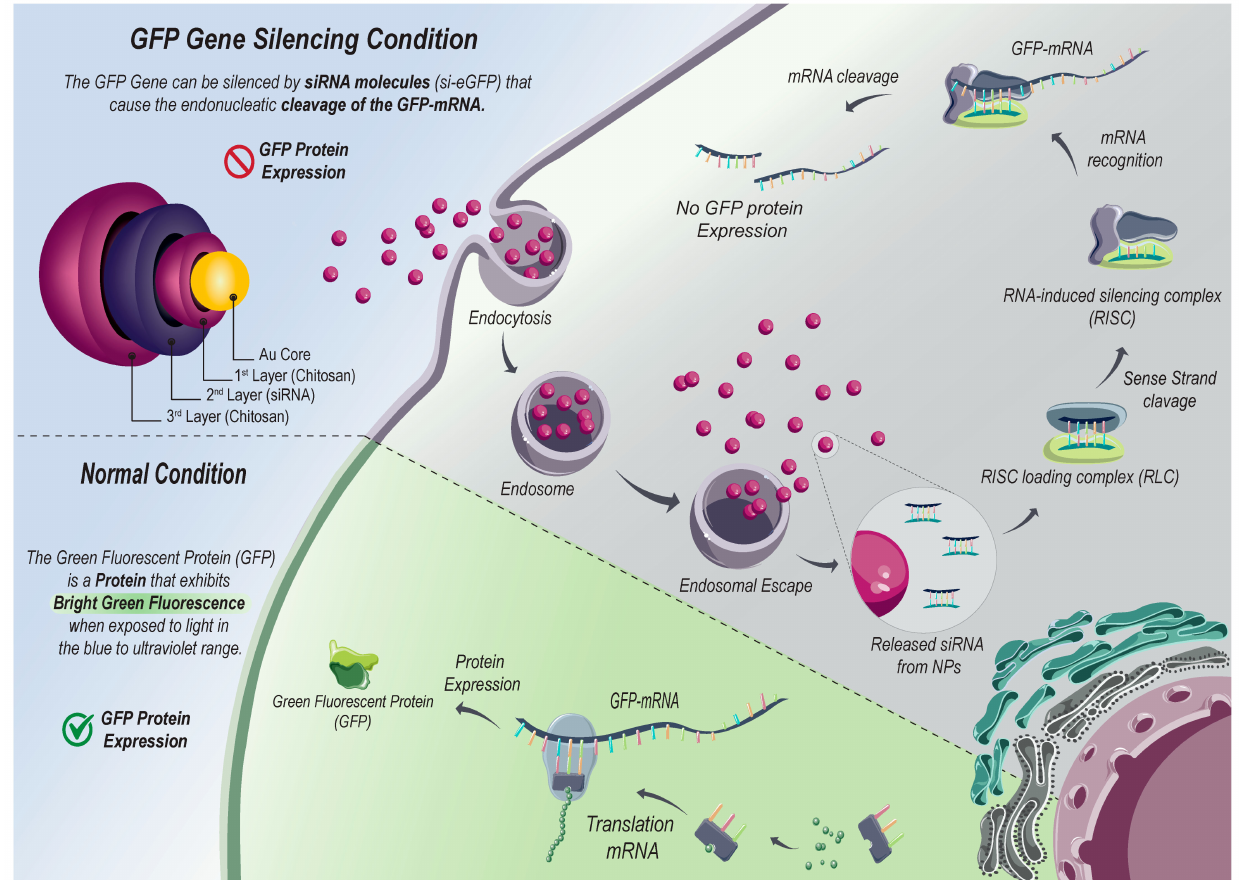
Scheme 1. Schematic representation of LBL-CS-AuNPs for siRNA delivery. Under normal conditions, H1299-eGFP cells continuously express enhanced Green Fluorescent Protein (eGFP). When LBL-CS-AuNPs are taken up by cells via endocytosis, chitosan can induce endosomal escape. Then, the released siRNA (si-eGFP) is processed by the RNA-induced silencing complex (RISC), which targets and cleaves GFP-mRNA. The cleavage of GFP-mRNA leads to decreased GFP expression and a diminished green fluorescence intensity of H1299-eGFP